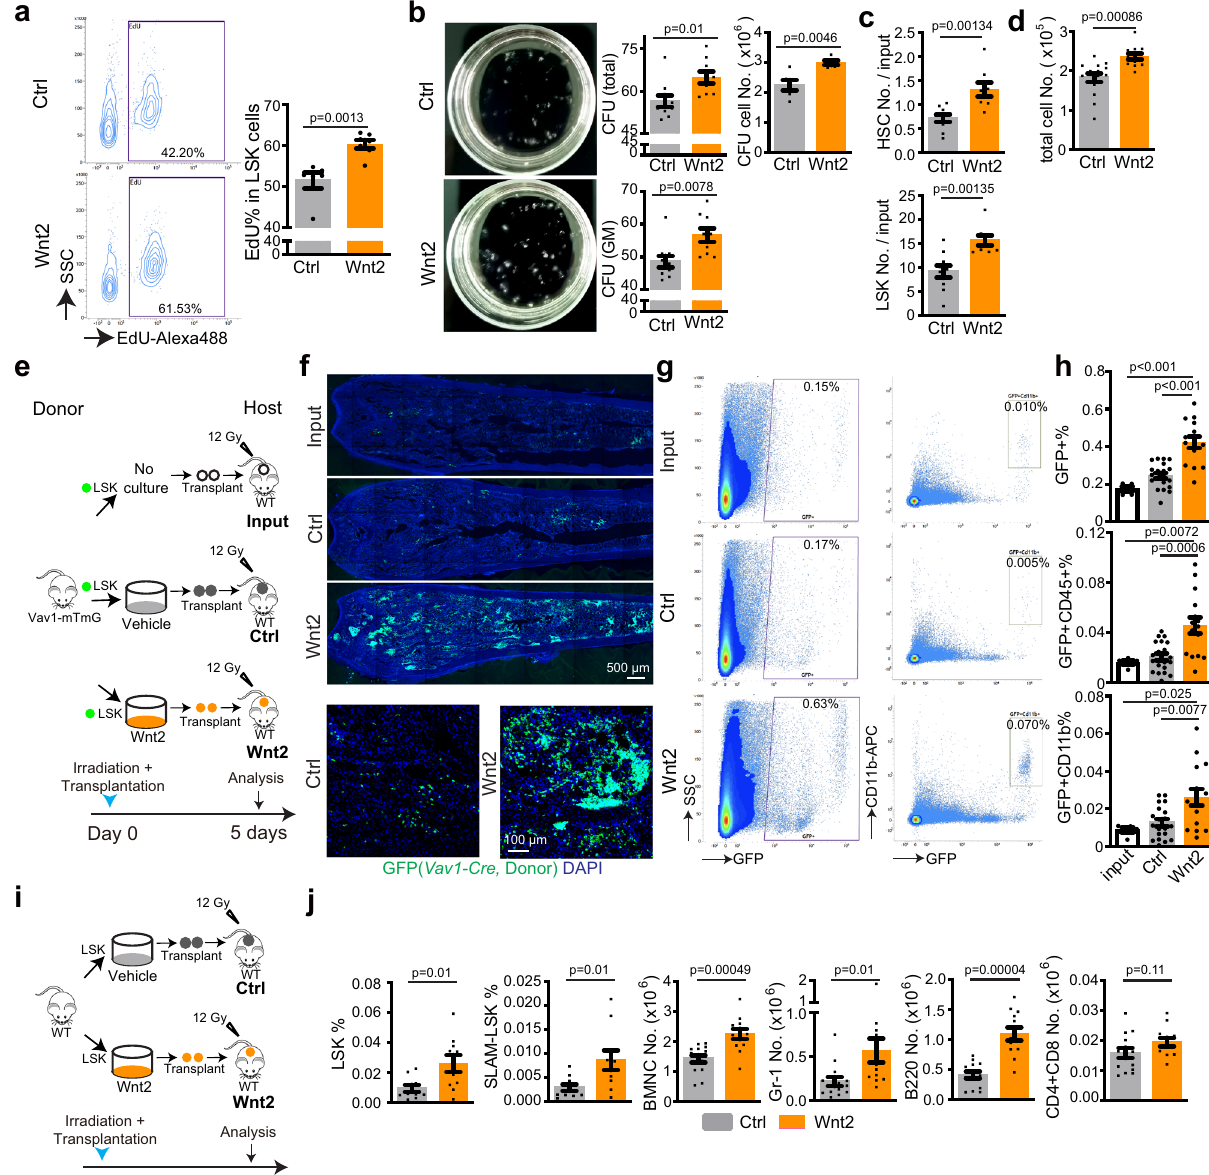
Fig. 7 Wnt2 promotes HSPC proliferation and transplantation. a Representative FACS plot showing transient EdU incorporation into sorted LSK cells after treatment with Wnt2 or vehicle. Quanti fi cation of EdU% in LSK cells. Ctrl = 6; Wnt2 = 7. Error bars, mean ± s.e.m. Two-tailed Student ’ s t test. b Representative images (8 days after seeding) and quanti fi cation of colony forming units from 600 isolated wild-type adult LSK cells. For colony count, vehicle = 10; Wnt2 = 9. For total cell number count, vehicle = 6; Wnt2 = 5. Error bars, mean ± s.e.m. Two-tailed Student ’ s t test. c , d Quanti fi cation of HSC number and LSK number fold change relative to adult cell input ( c ); vehicle = 10; Wnt2 = 9. Absolute cell number after Wnt2 treatment ( d ); vehicle = 15; Wnt2 = 14. Error bars, mean ± s.e.m. Two-tailed Student ’ s t test. e Diagram showing Wnt2-treatment of sorted adult Vav1-mTmG LSK cells in vitro followed by analysis at 5 days after transplantation into lethally-irradiated WT mice. f Representative overview and high-magni fi cation immunostaining results showing hosts bone sections at 5 days after transplantation with Wnt2 or vehicle-pretreated GFP + cells or fresh input cells. g FACS plot showing GFP + or GFP + CD11b + cells from hosts at 5 days after transplantation with Wnt2 or vehicle-pretreated GFP + cells or fresh input cells. h FACS based quanti fi cation of GFP + , GFP + CD45 + and GFP + CD11b + cell percentage in BM at 5 days after transplantation. Input = 5; ctrl = 20; Wnt2 = 15. Error bars, mean ± s.e.m. Two-tailed Student ’ s t test. i Diagram showing Wnt2-treatment of sorted adult WT LSK cells in vitro followed by analysis at 2 weeks after transplantation into lethally-irradiated WT mice. j FACS based quanti fi cation of LSK%, SLAM-LSK% (ctrl = 10; Wnt2 = 10) as well as the number of BMNCs, Gr-1 + myeloid cells, B220 + B-lymphocytes and CD4/8 + T-lymphocytes. ctrl = 14; Wnt2 = 12. Error bars, mean ± s.e.m. Two-tailed Student ’ s t test. immunostaining, bone sections were rehydrated in PBS, permeabilized for 15min Embryonic legs were dissected and immediately placed in ice-cold 4% in 0.5% Triton-X100 PBS solution and blocked for 30 min in PBS containing 1% paraformaldehyde solution and fi xed under gentle agitation overnight. Leg samples BSA, 2% donkey serum, 0.3% Trion-X100 (blocking buffer) at room temperature. were placed in 0.5M EDTA (PH 8.0) for 1 day, dehydrated in 20% sucrose and 2% Sections were incubated with primary antibodies diluted in blocking buffer at 4 °C polyvinylpyrrolidone-containing PBS for 1 day, and embedded in PBS containing overnight. After incubation, sections were washed three times with PBS and 20% sucrose, 8% gelatin and 2% polyvinylpyrrolidone for storage at − 80°C and incubated with appropriate Alexa Fluor-conjugated secondary antibodies (1:100 to cryosectioning on a Leica CM3050 cryostat using low pro fi le blades. For NATURE COMMUNICATIONS| (2022) 13:1327